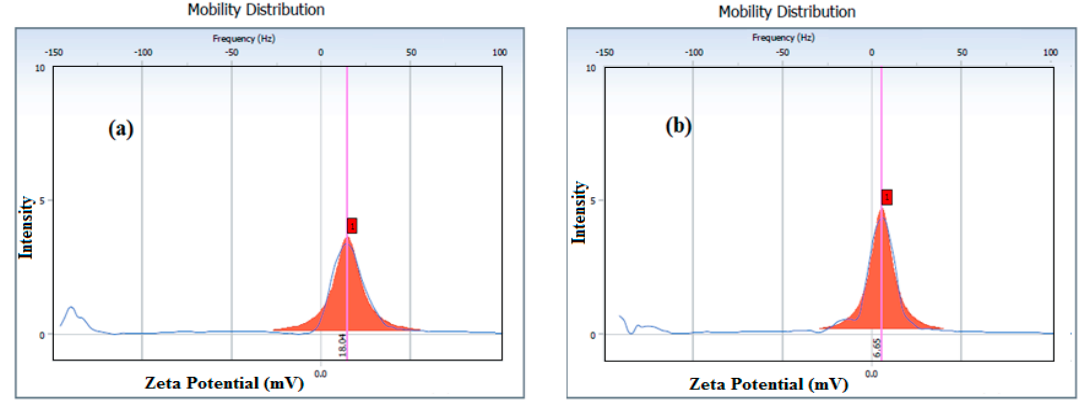
Figure 6. Zeta potential (mV) data of a ) HSNP-1 and b ) HSNP-2 in methanol at 25 °C.